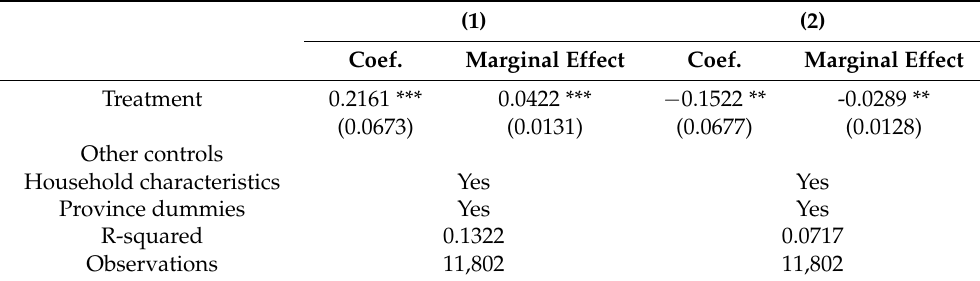
Table 6. Possible mechanisms: social integration and rural place attachment. (1) (2) Coef. Marginal Effect